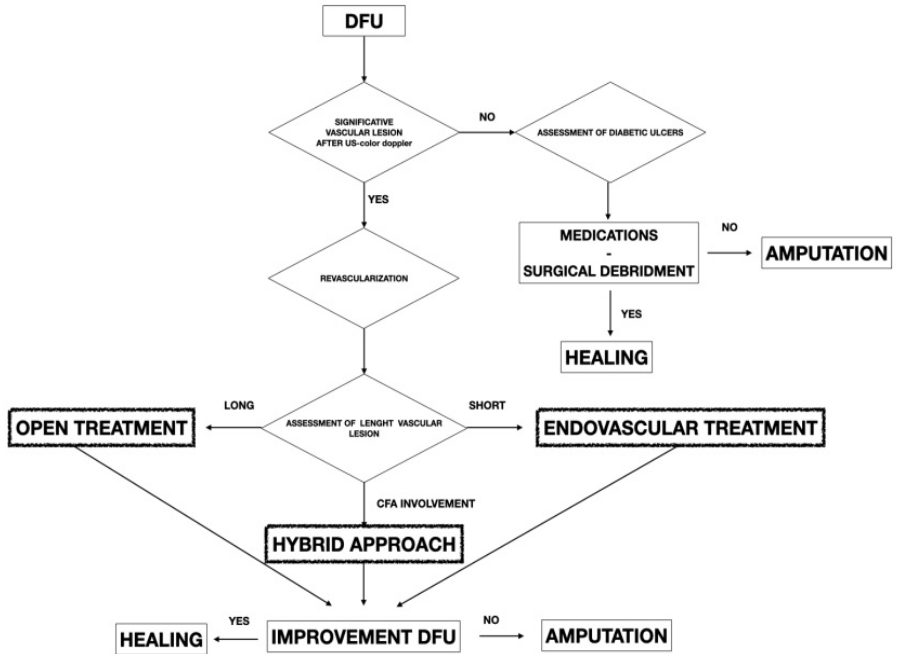
Figure 1. Flowchart showing the decisional algorithm employed in patients presenting PAD with DFU.